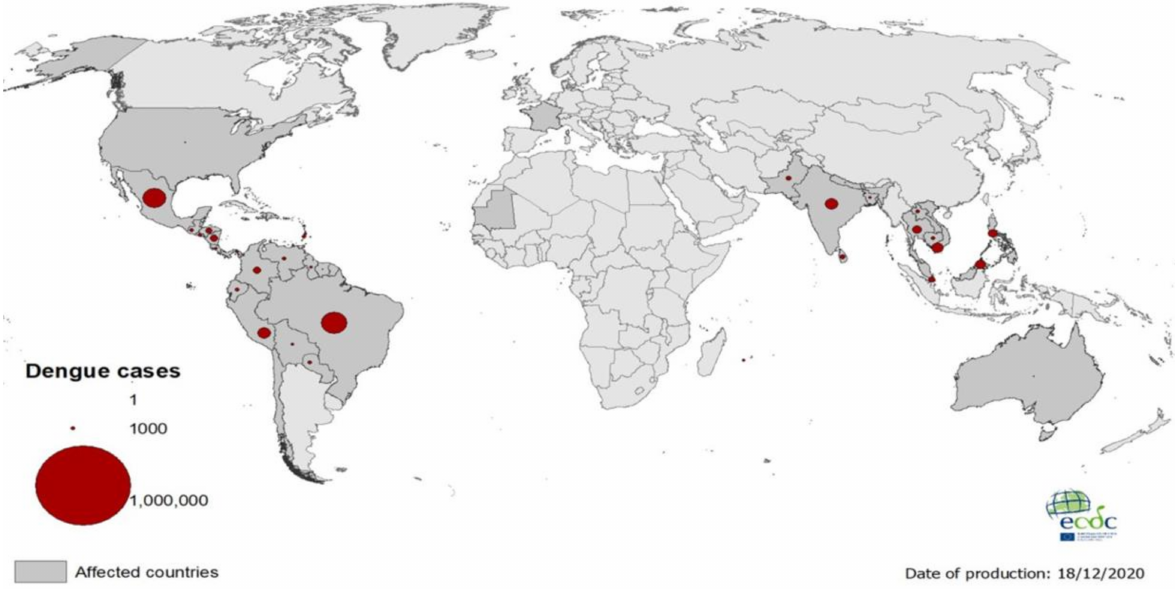
Figure 1. The global map for the prevalence of Dengue fever as of 18 December 2020 (Source: European Centre for Disease Prevention and Control).